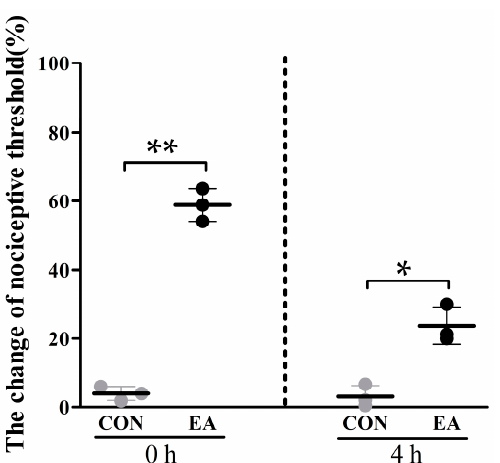
Figure 1. Analgesic effects induced by EA in goats (mean ± SD, %, n = 3). The nociceptive thresholds were measured with potassium iontophoresis. Nociceptive threshold increased at 0 and 4 h after EA stimulation. Goats in the control group were restrained as goats in EA group without needling and electricity. The significance of differences (** p < 0.01, * p < 0.05) was calculated by a t -test. The grey dots represent the control group. The black dots represent EA group.